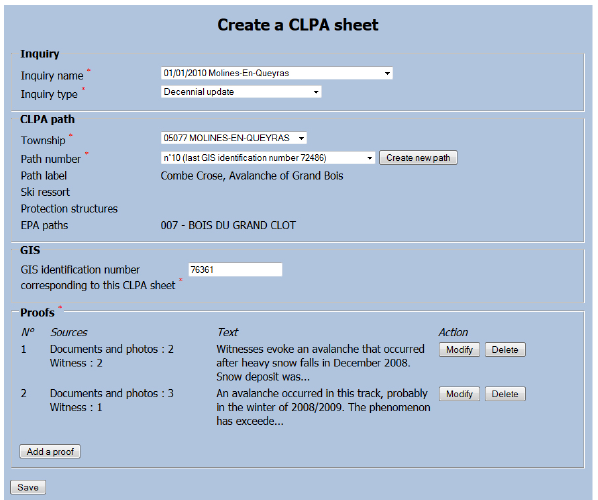
Figure 9. Graphical user interface of the data entry level to create a CLPA